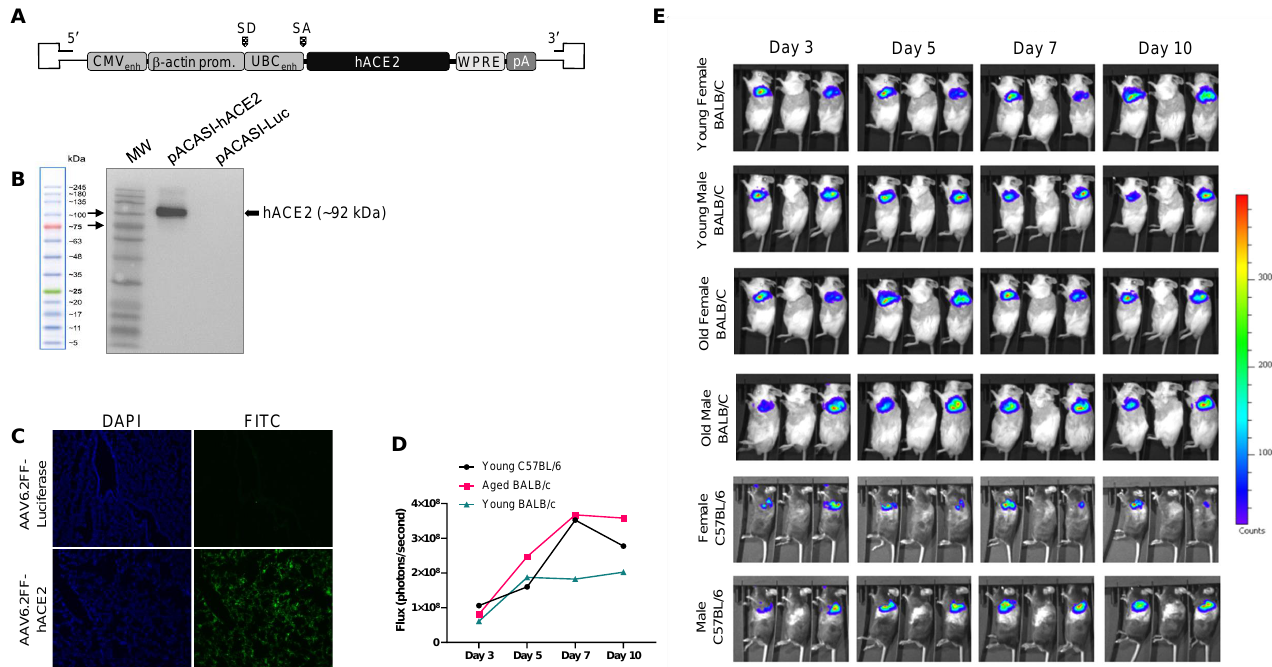
Figure 1. ( A ) Schematic of the AAV genome expressing human ACE2 (hACE2) under the control of the composite CASI promoter (containing cytomegalovirus immediate early promoter (CMV), chimeric chicken- β -actin (CAG), and ubiquitin C (UBC) enhancer region) and flanked by a Woodchuck Hepatitis Virus Posttranscriptional Regulatory Element (WPRE) and an SV40 polyA sequence (pA) as well as splice donor (SD) and acceptor (SA) sequences. ( B ) HEK 293 cells transfected with pACASI- hACE2-WPRE or pACASI-Luc-WPRE ( C ) Immunofluorescence staining of mouse lung sections demonstrating widespread hACE2 expression in AAV6.2FF-hACE2-transduced mice at 10 days post-vector administration. ( D ) Quantification of luciferase expression in AAV-Luciferase-transduced mice. ( E ) IVIS imaging of AAV-Luc (right and left) transduced mice and AAV-hACE2-transduced mice (middle). Total mice per transduced group (Luc or hACE2) is 6 (3 male and 3 female) with representative imaging shown for 3 mice per day per